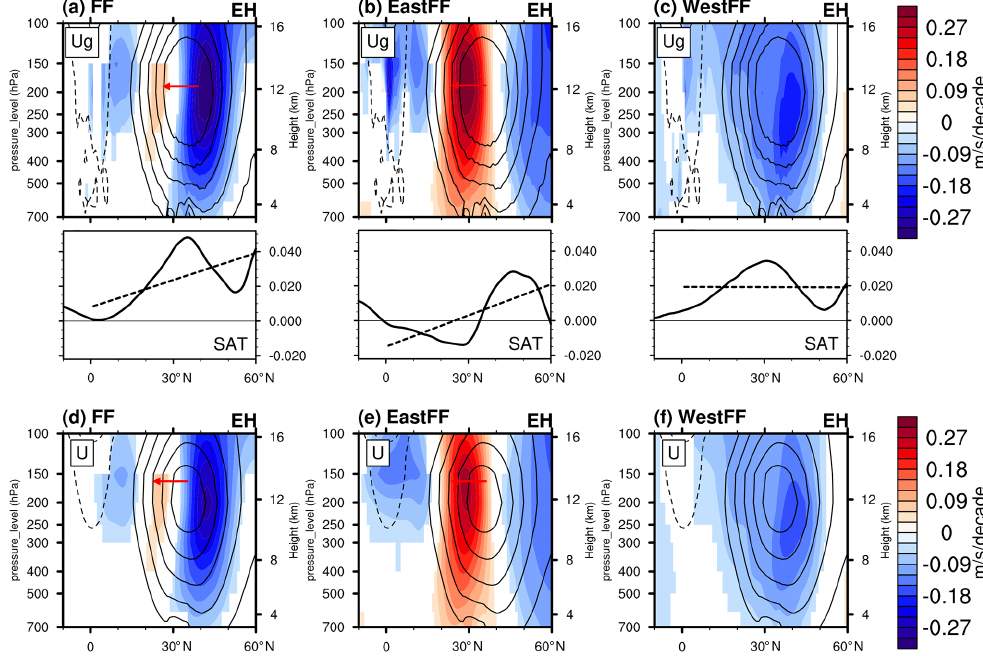
Figure 8. Panels (a–c) are similar to Fig. 6d–f but for the geostrophic wind ( U g ) trend (ms − 1 per decade) derived from geopotential height ( Z ) during 1980–2020 in Eastern Hemisphere (EH). The climatology is shown in contour lines with an interval of 6. The positive values indicate a westerly wind. The statistically insignificant trend is masked in white. The arrows indicate the latitudinal shift in each case. The profiles below show the gradient of the surface air temperature trend (black curves; W/m 2 per decade per 10 ◦ lat). The gradient lines are smoothed using the moving average method (with 30 ◦ of the latitudinal range sampling window). The dashed lines are the linear fit from 0 to 60 ◦ N. Positive values indicate a larger SAT trend at higher latitude and vice versa. Panels (d–f) are similar to the bottom row of Fig. 6 but for the U trend in the Eastern Hemisphere (EH) in response to three types of